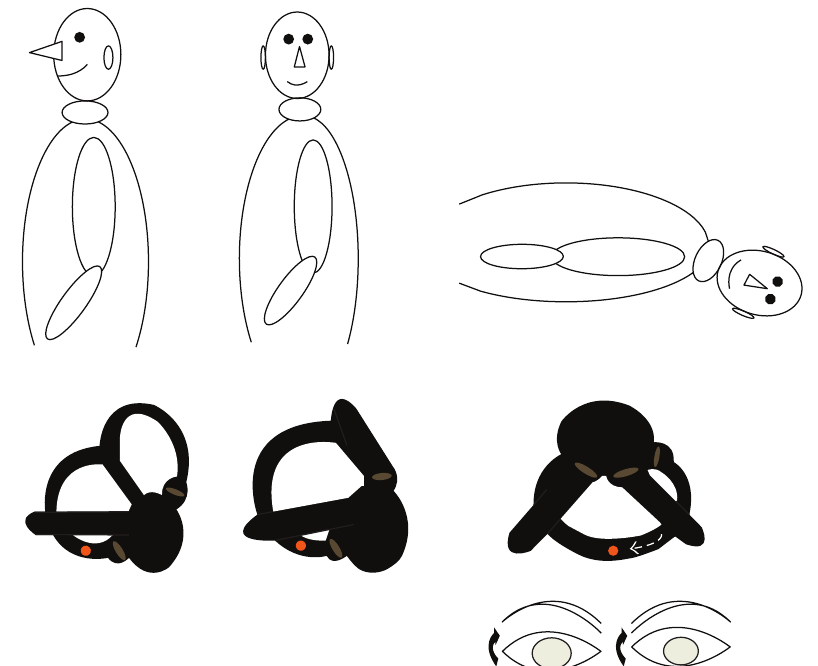
Figure1:Schematicviewofrotatory,torsional,andupbeatingnystagmus(clockwise)duringhead-hangingpositioninapatientwithcommon left-sided PC-BPPV (dark arrow indicates the direction of the